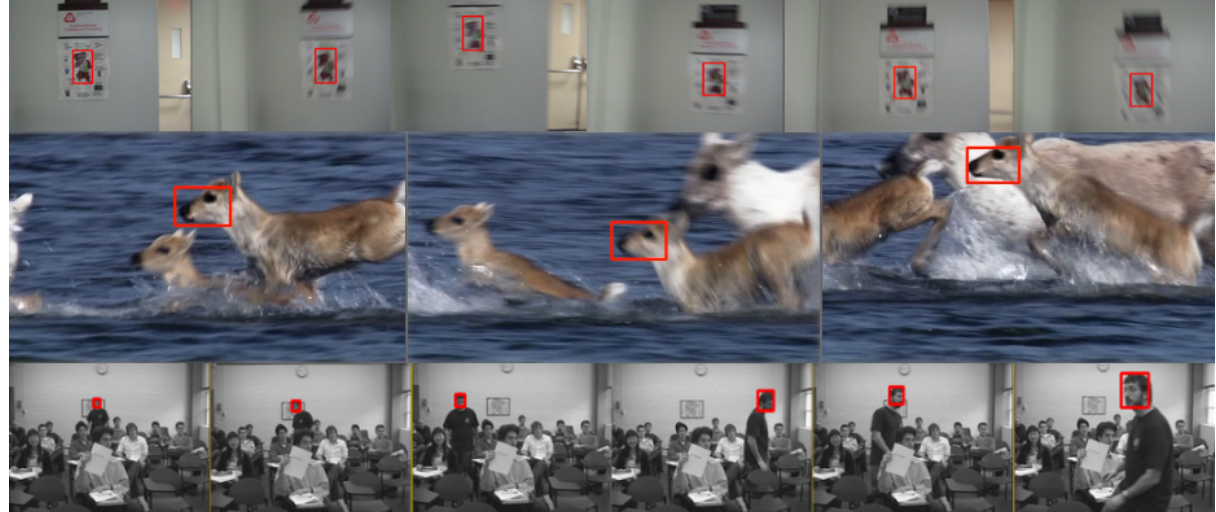
Figure 11. Several challenging video sequences in OTB-2015involving a fuzzy objective. From top to bottom, pictures are: BlurOwl, Deer, Freeman3. The attributes are MB, FM, and LR. In these two scenarios, the tracking recognition effect is good and there is no significant drift or tracking failure.